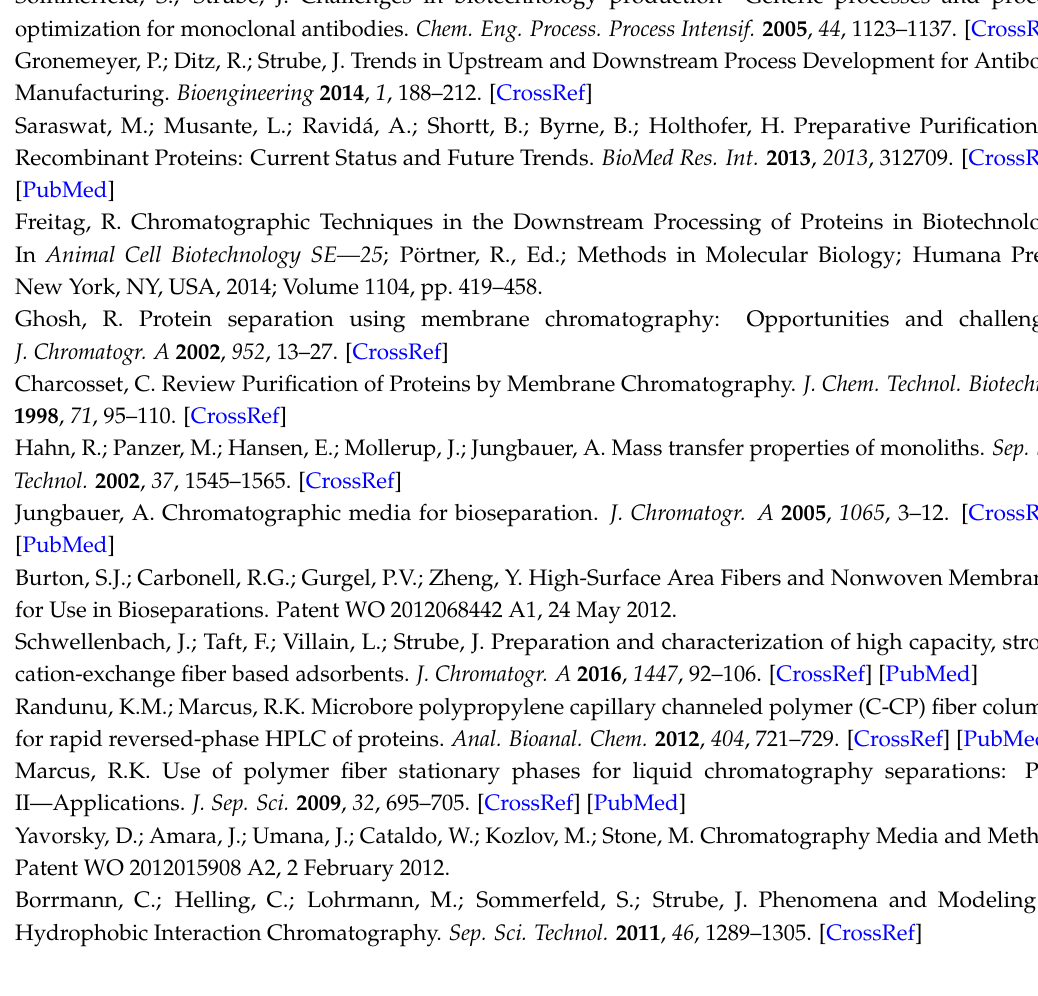
Figure S2: comparison between a measured and simulated tracer signal for the external system